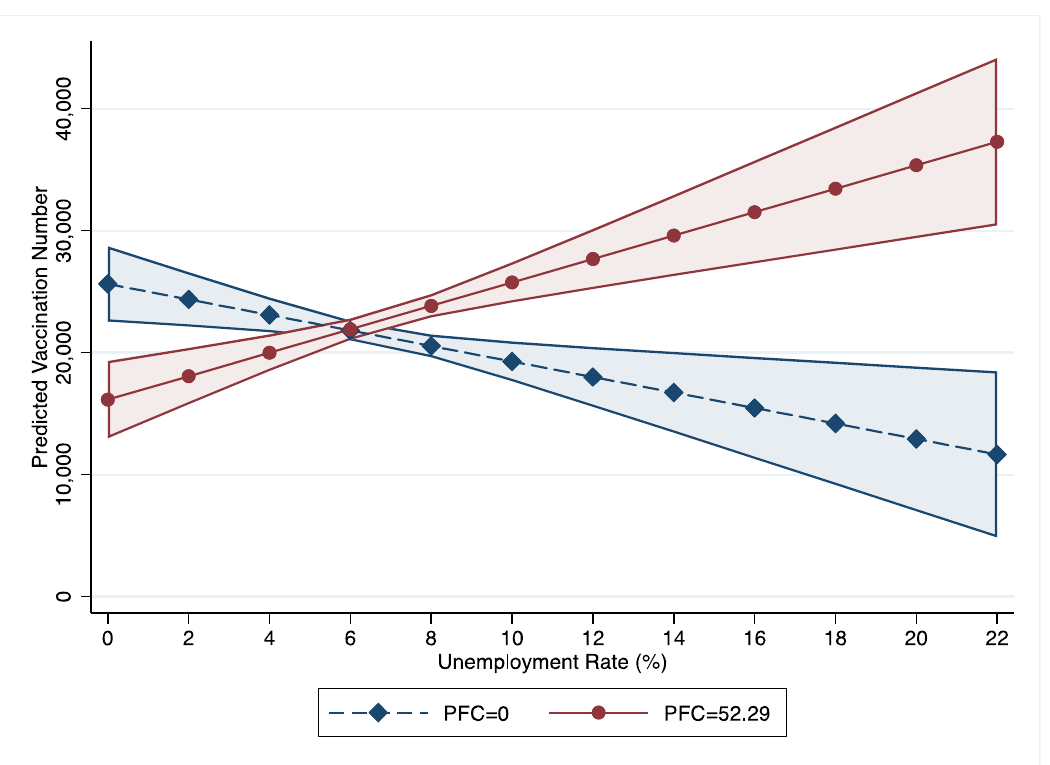
Figure 2. Interaction Effects between PFC and Unemployment Rate.